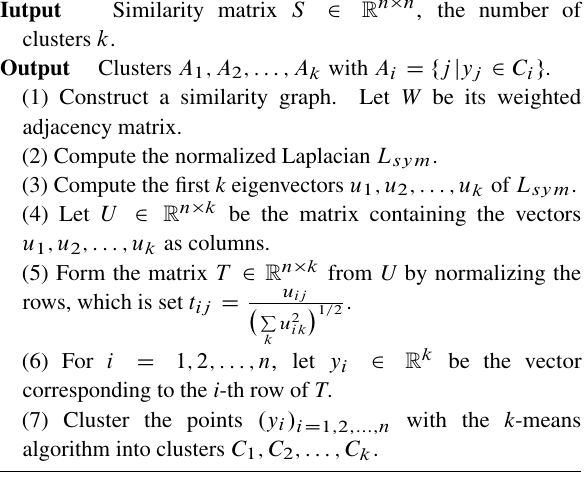
Algorithm 6 Spectral clustering